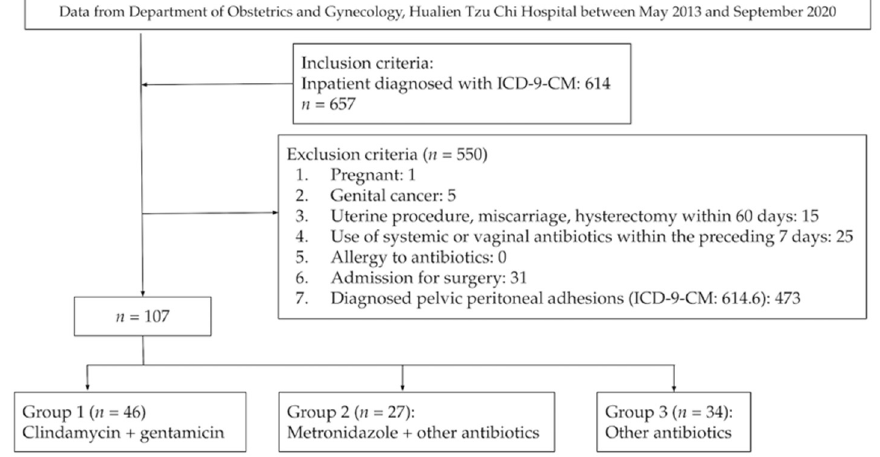
Figure 1. Flow chart of study design. The 107 individuals were divided into three groups based on their antibiotic